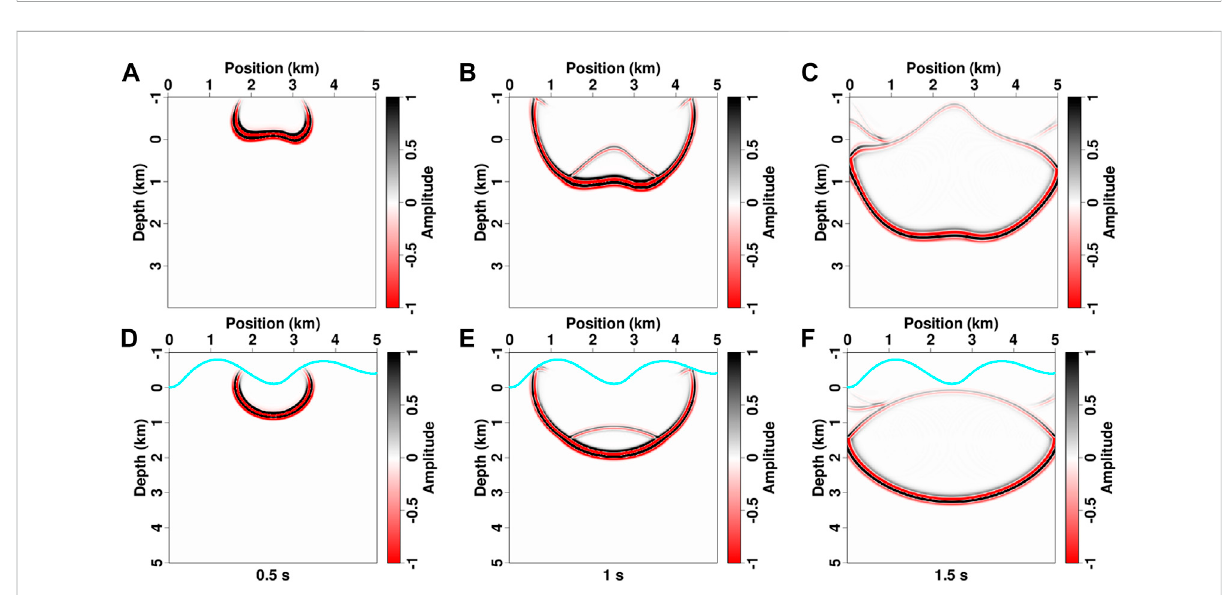
FIGURE 6 Viscoacoustic wave fi elds of different propagation times with a free-surface boundary in the computational domain (A – C) and physical space (D – F) . The cyan lines in panels (D – F) denote the topography.